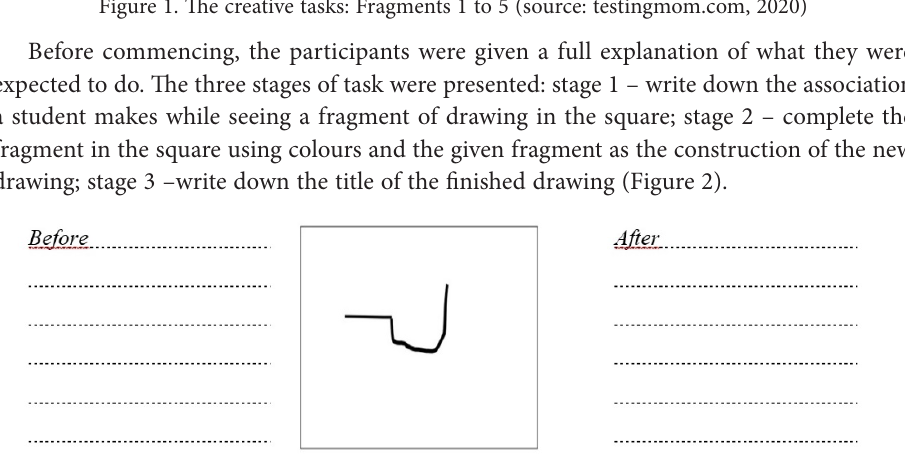
Figure 2. Presentation of a three-stage creative task (source: testingmom.com,